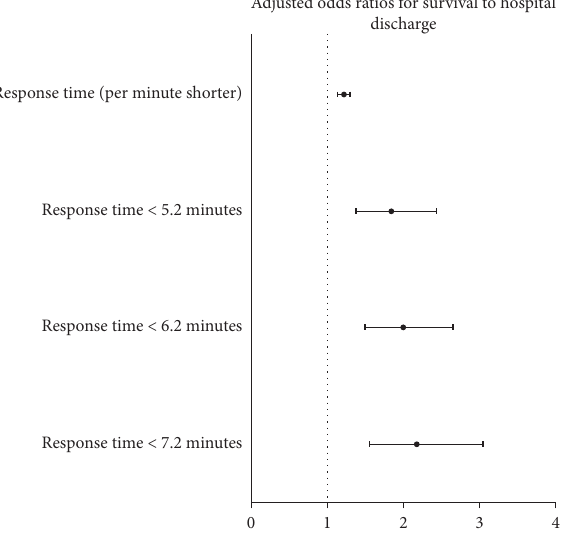
Figure 1: OR and 95% CI for survival to hospital discharge in OHCA patients after adjusting for age, witness presence, public location, bystander CPR, EMT-P attendance, and prehospital defibrillation by